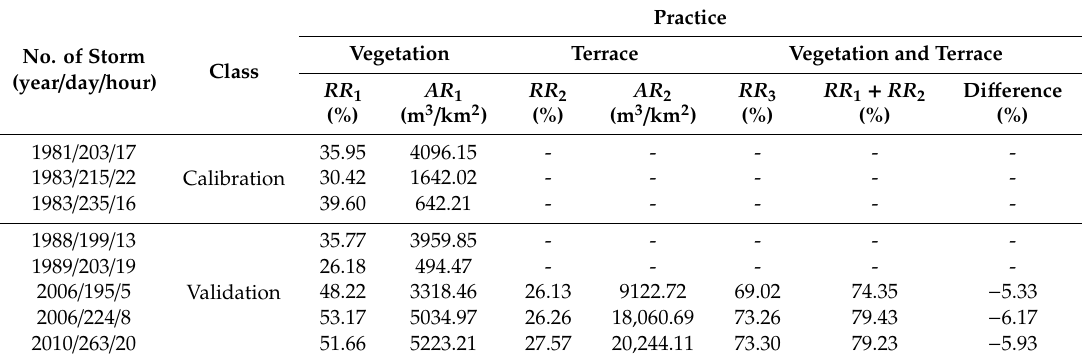
Table 6. The e ffi ciency of runo ff reduction by vegetation and terraces in Pianguanhe Basin.